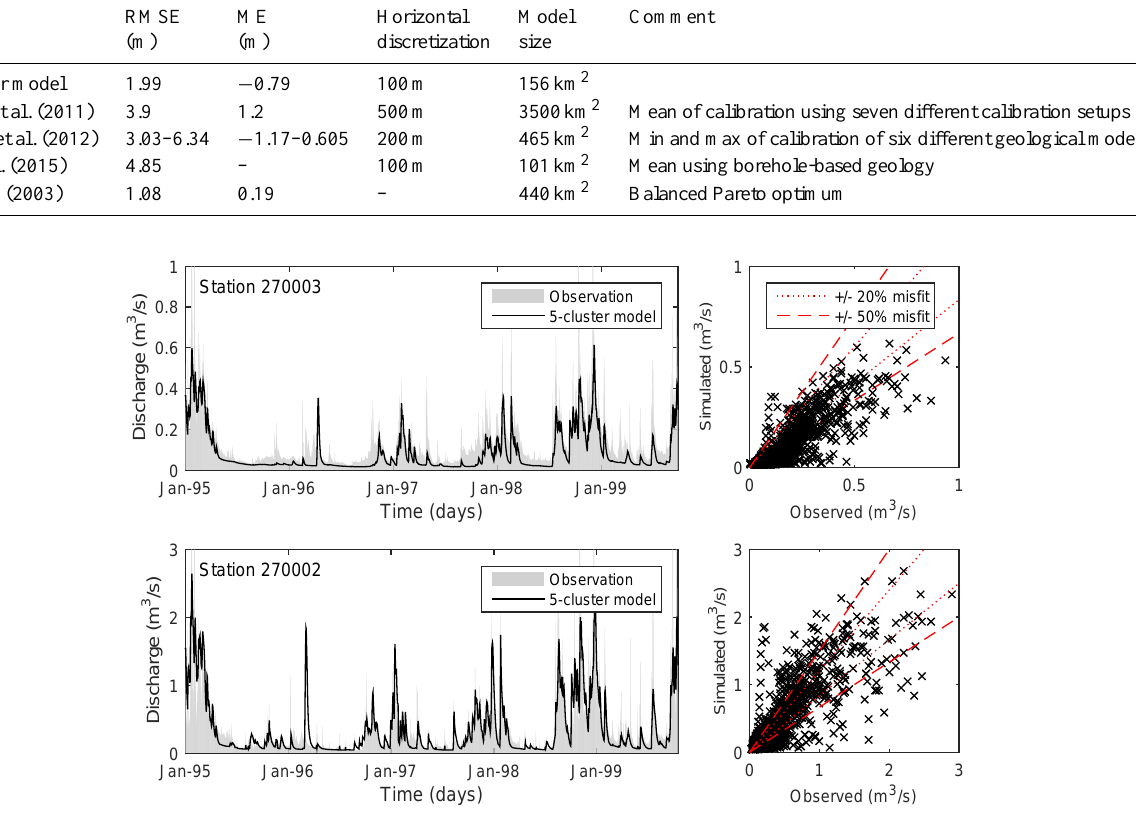
Figure 10. Observed and simulated stream discharge at stations 270003 (top row panels) and 270002 (bottom row panels) from the 1995– 1999 validation period. To the left stream discharge hydrographs are shown and to the right scatter plots of observed vs. simulated values. In the scatter plots the dotted and dashed red lines mark misfits of 20 and 50%, respectively.